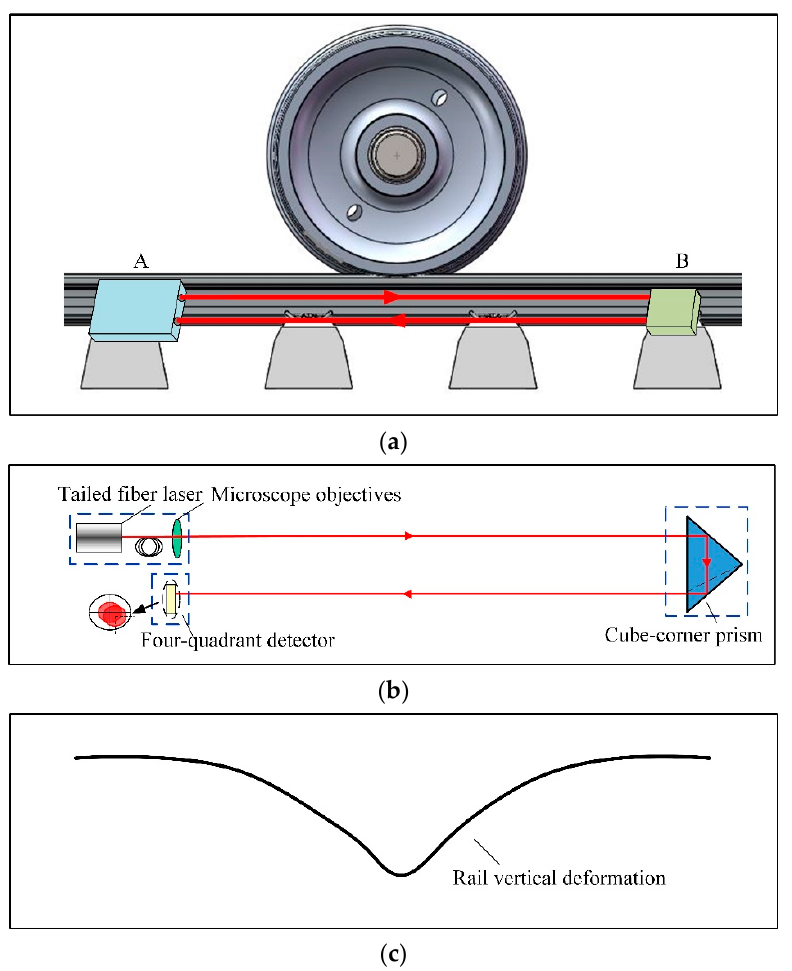
Figure 2. The schematic diagram of the installed sensor modules and the rail vertical deformation: ( a ) The installation location of the sensor; ( b ) The schematic diagram of the sensor; ( c ) The rail vertical deformation.